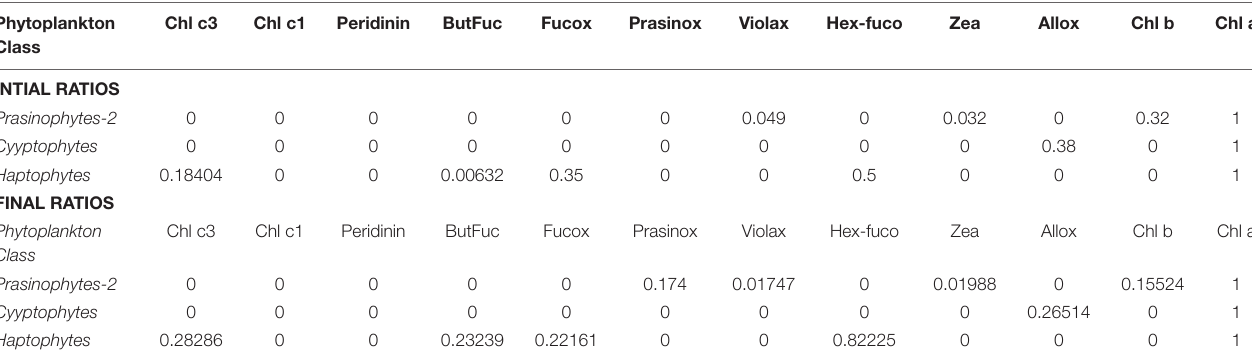
TABLE 1 | Initial pigment: Chl a ratios entered into the CHEMTAX program are from Higgins et al. (2011), Swan et al. (2016) and Wright, S. (personal comm.), and Final ratios are the output after completion of CHEMTAX runs. Phytoplankton Chl c3 Chl c1 Class INTIAL RATIOS Cyyptophytes